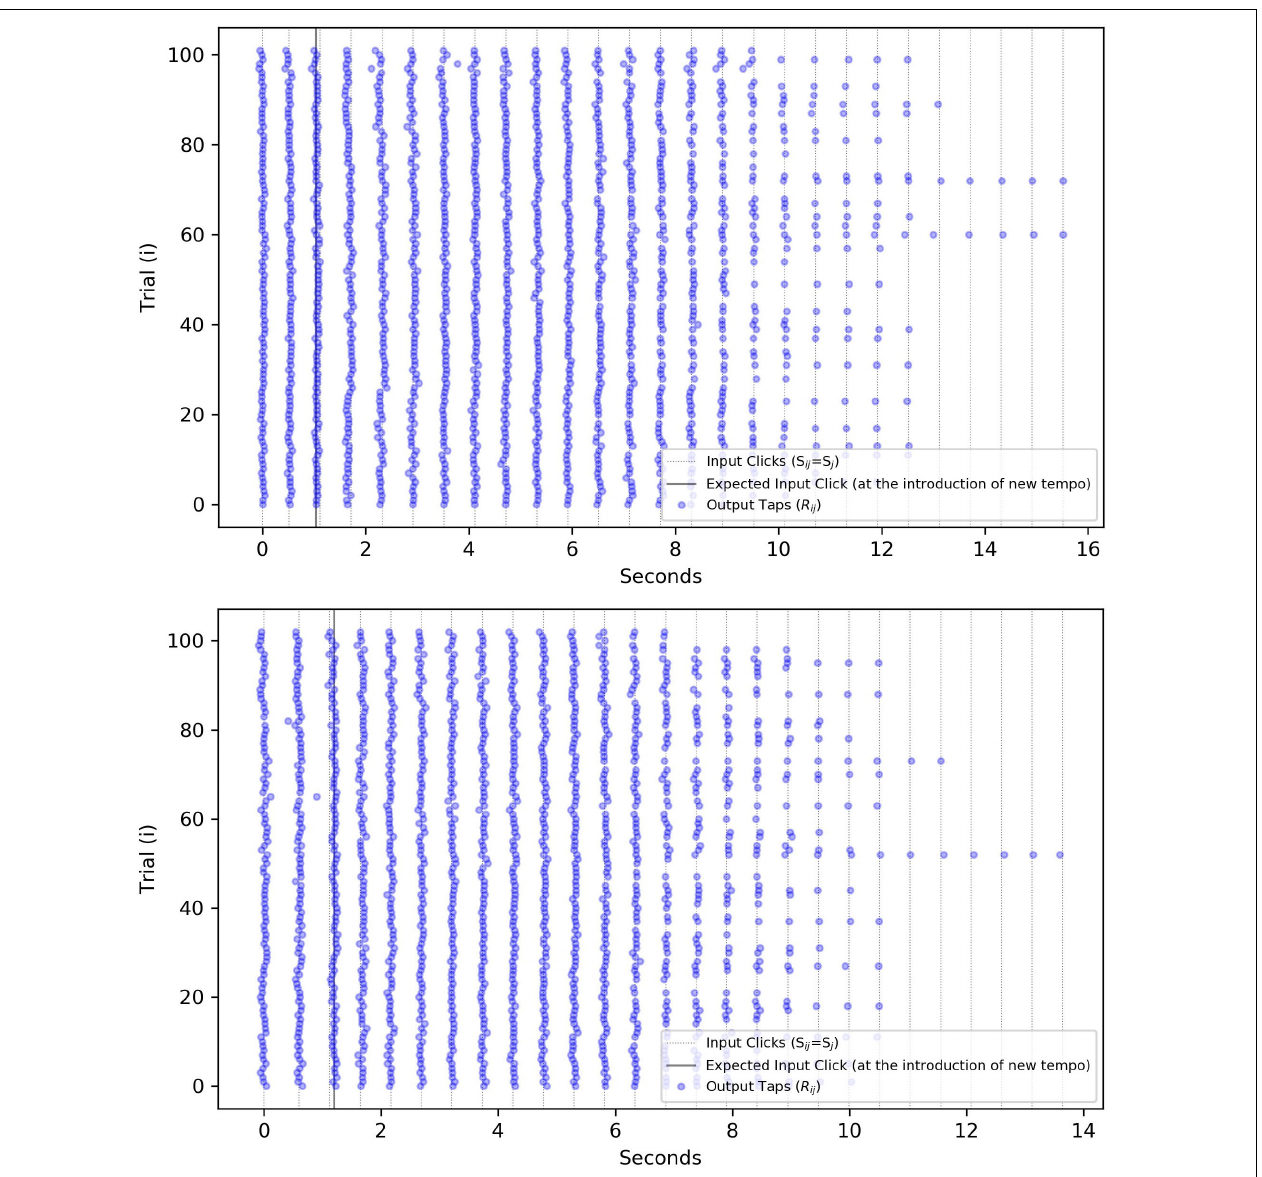
FIGURE 2 | Visualization of the “event” variables for a specific subject/step size and for both positive/negative cases (Positive steps start in the range of 103–200 bpm and with an increase in ISI/IRI, or a decline in tempo jump to 100 bpm. Negative steps begin with 100 bpm in the tempo and with a decrease in the IOI, jump to a higher tempo.). (Top) A positive step: 102 repetitions of one participant’s responses to a tempo change from 115 to 100 bpm (increasing ISI from 0.522 to 0.6 s). The solid line shows where a stimulus onset was expected by the subject but occurred later due to the increase in ISI. (Bottom) A negative step: 103 repetitions of the same participant responding to the tempo change from 100 to 115 bpm (decreasing ISI). The solid line shows that the first click after the tempo change, arrived slightly later than expected. The horizontal axis is transformed to time instead of tap index to mark at which timestamp the input and output onsets have